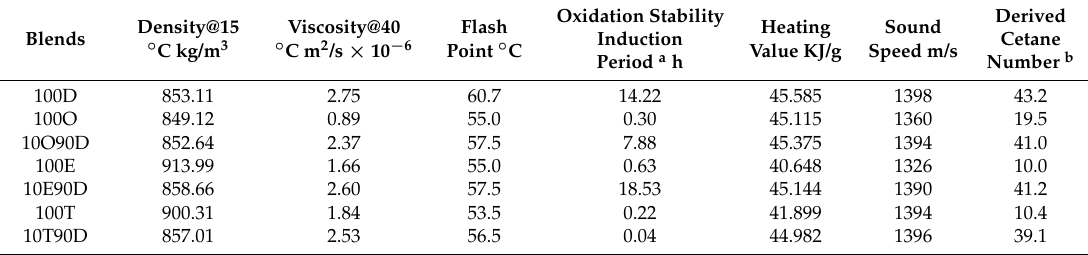
Table 2. Properties of fuel blends used for Derived Cetane Number testing at Colorado State University (CSU) adopted from